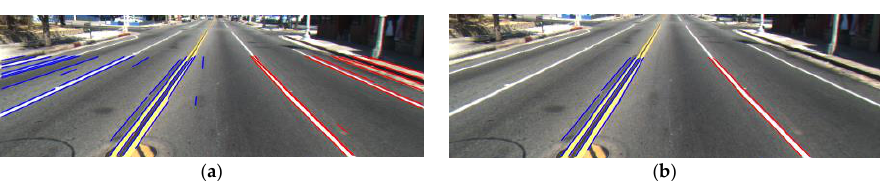
Figure 14. Number of detected line segment based on the angle condition: ( a ) Before using the angle condition; ( b ) After using the angle condition.